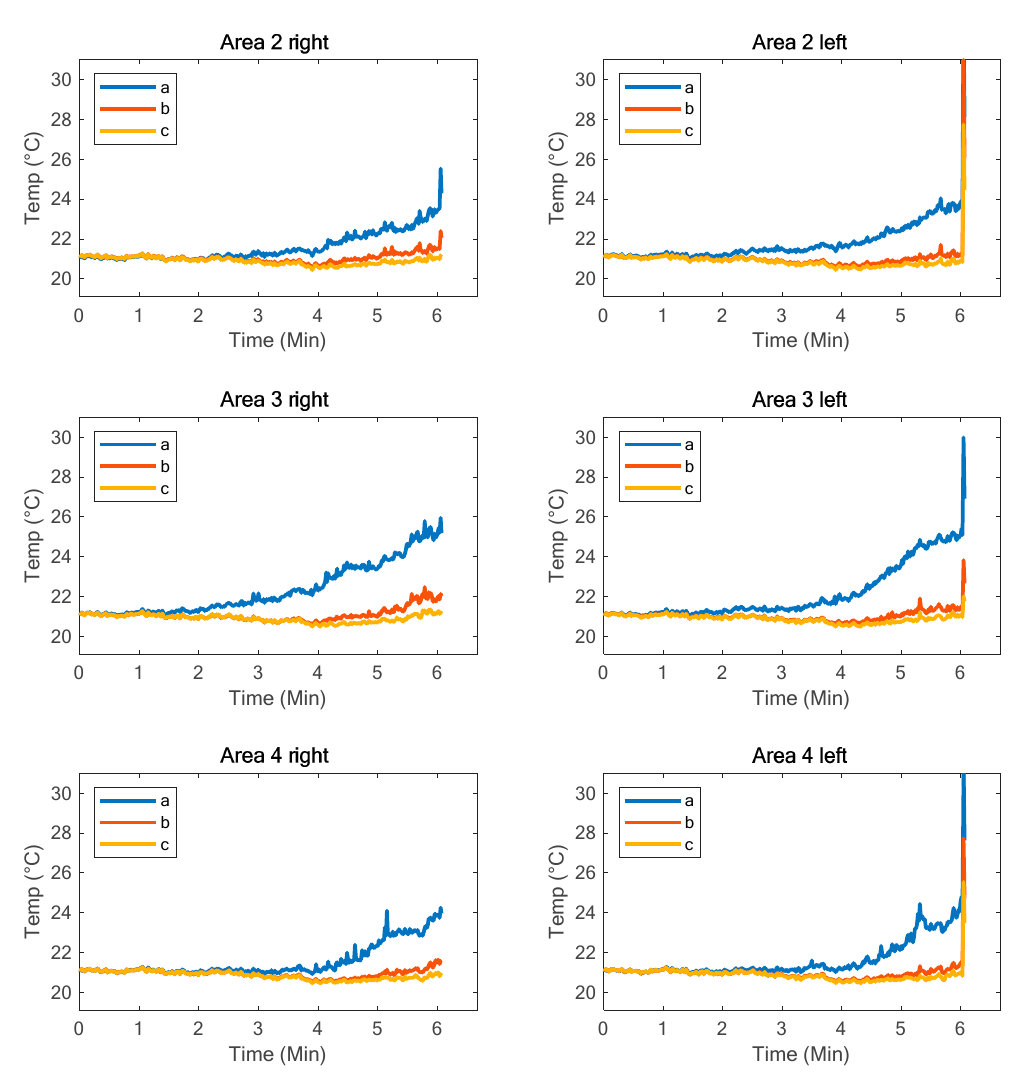
Figure 7. Average temperature of right and left trunk areas during the whole test.